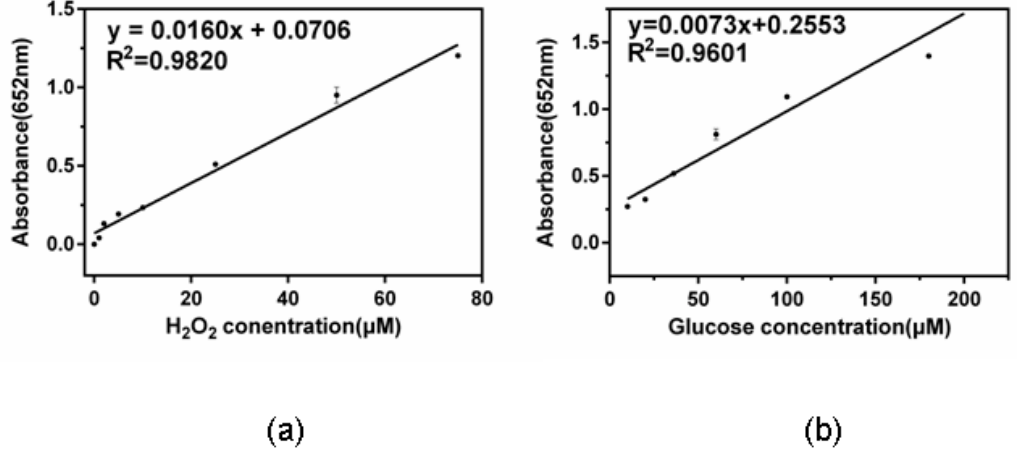
Figure 6. ( a ) Linear regression plot against different concentrations of H 2 O 2 ; ( b ) linear regression plot against different concentrations of glucose. Experiments were performed in triplicate to obtain the mean value.